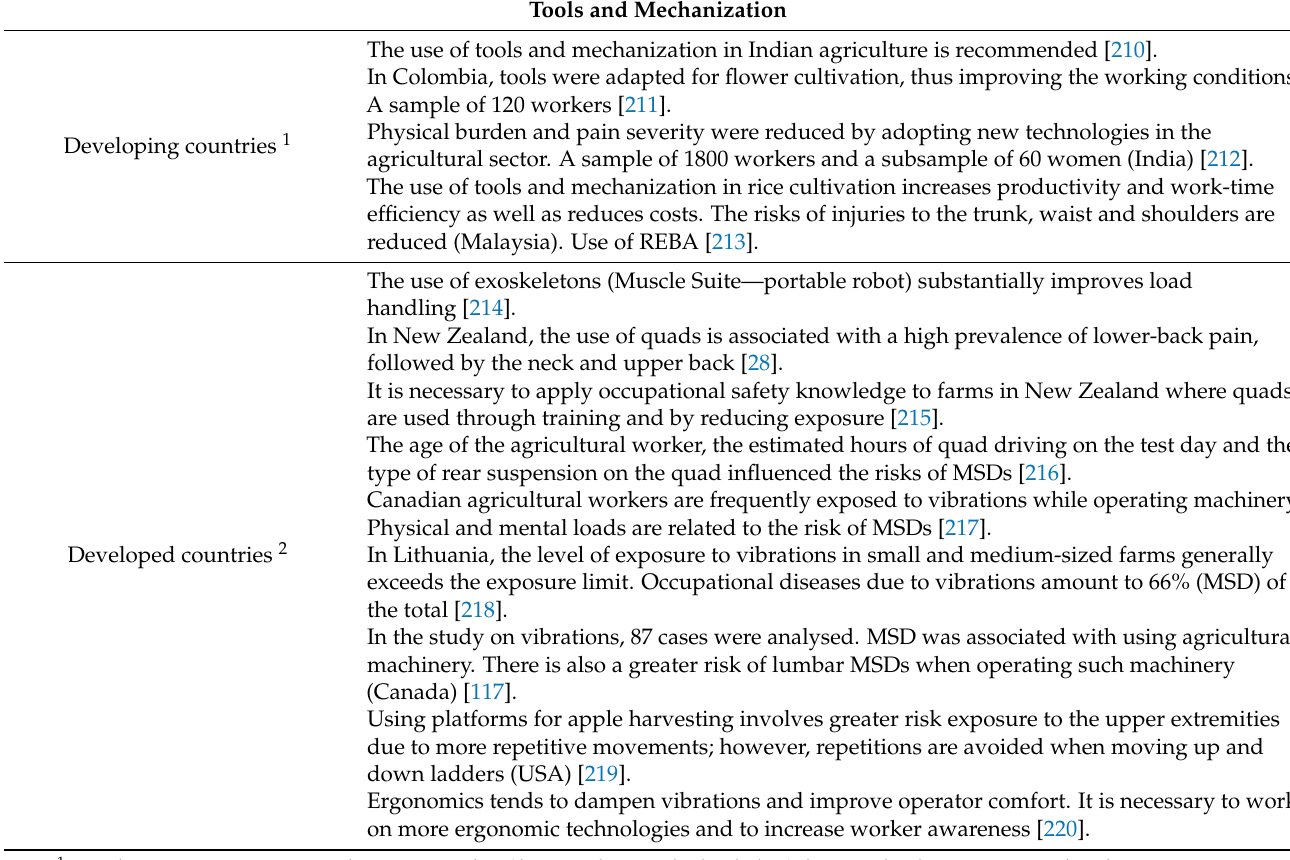
Table A18. MSD research in agriculture (1995–2020). Category: Tools and mechanization. Tools and Mechanization